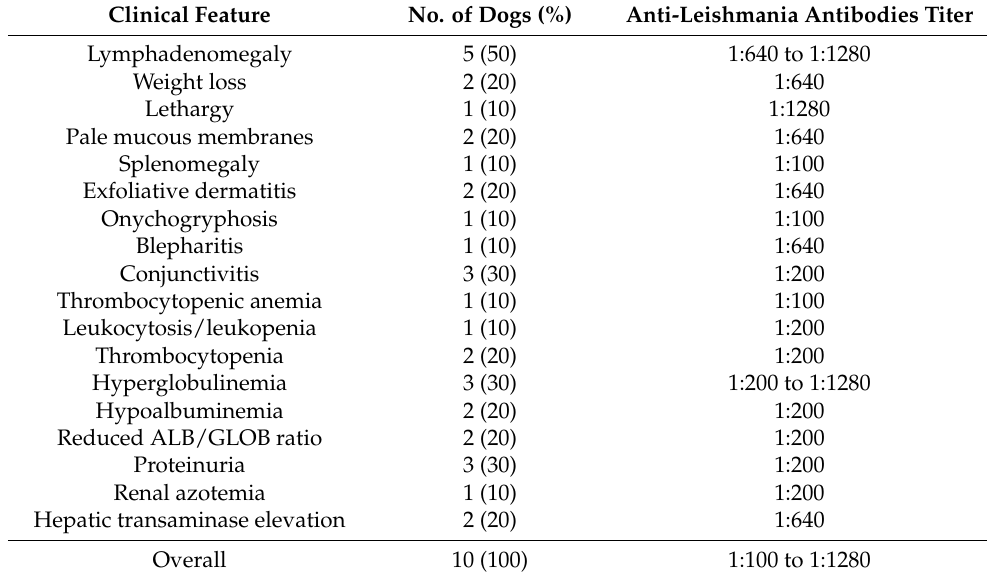
Table 2. Clinical features and anti- Leishmania antibodies titer observed in positive animals and its